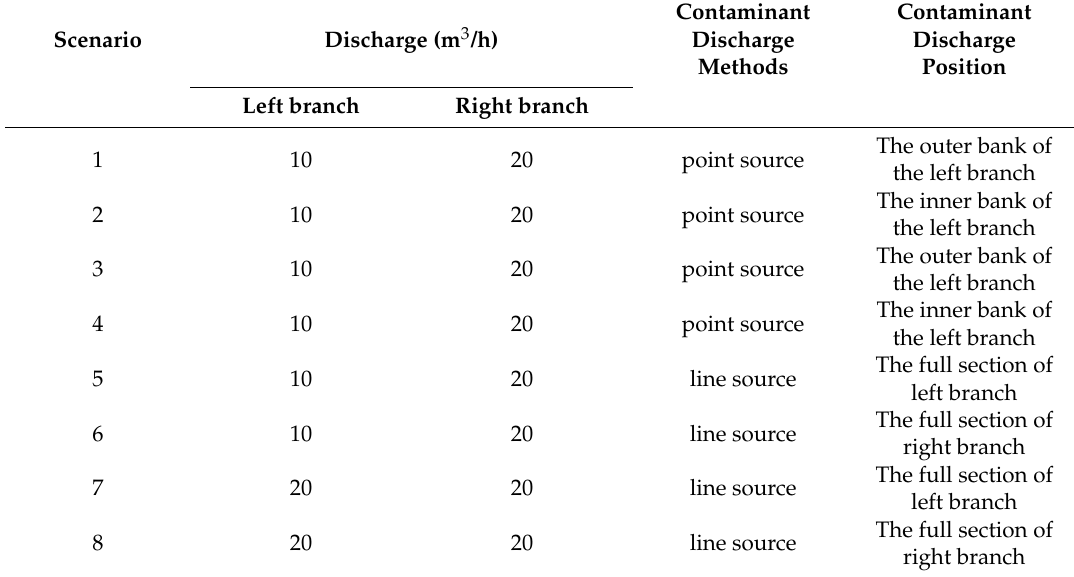
Table 2. The specific contaminant tracer discharge